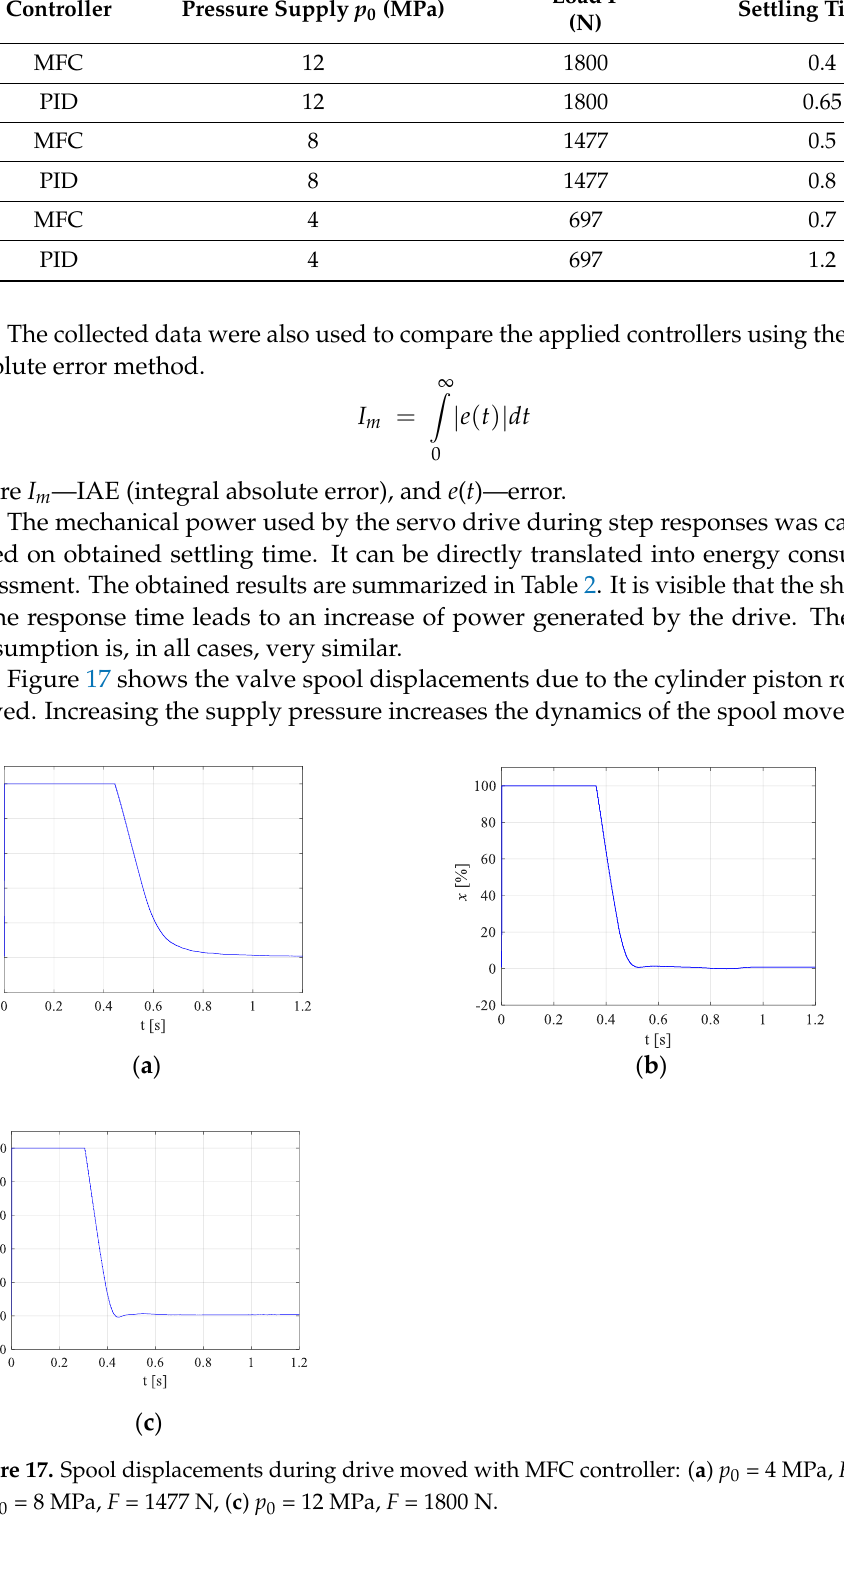
Table 1. Settling time comparison.